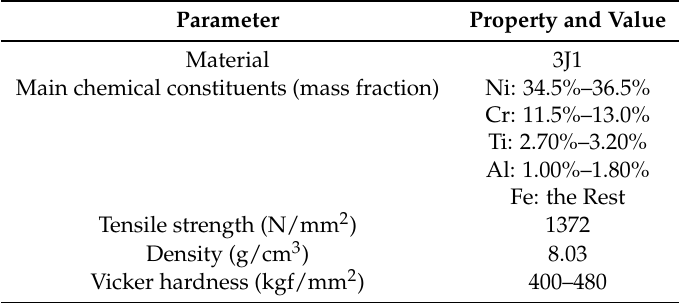
Table 2. Material Performance of 3J1